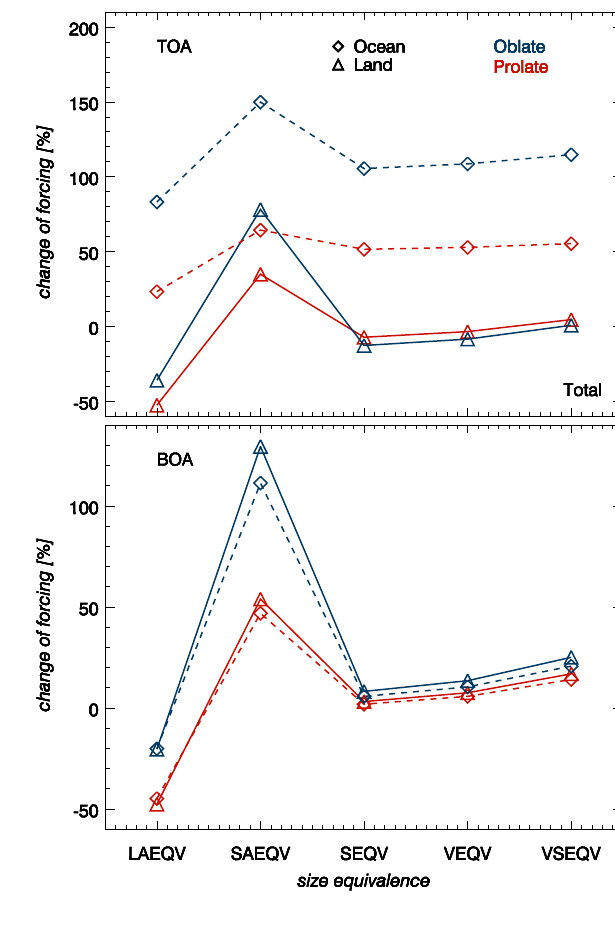
Fig. 17. The same as in Fig. 15, but for entire (total) spectral